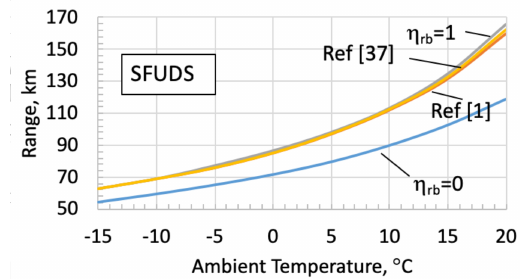
Figure 7. Impact of different regenerative braking assumptions on range in the case of SFUDS driving cycle.